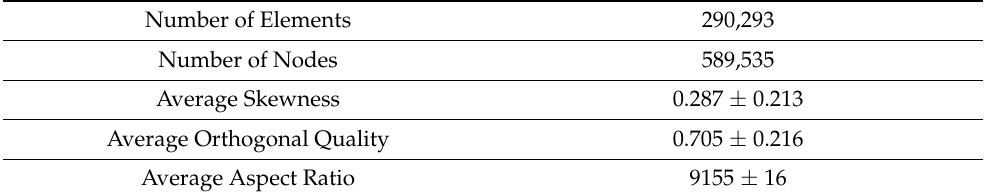
Table 1. Parameters for the evaluation of the mesh quality and correspondent standard deviation, as used in the less demanding